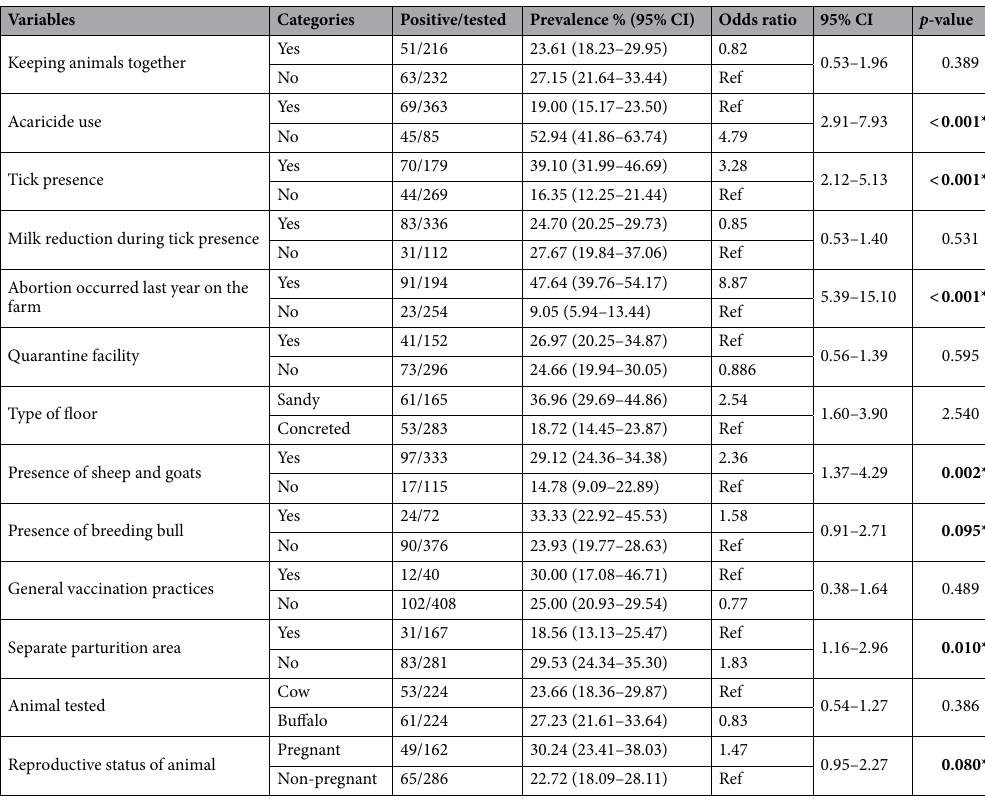
Table 4. Summary of the variables included in the univariable analysis to test for association with ELISA positive Q fever results. Ref reference category. Significant values are in bold.